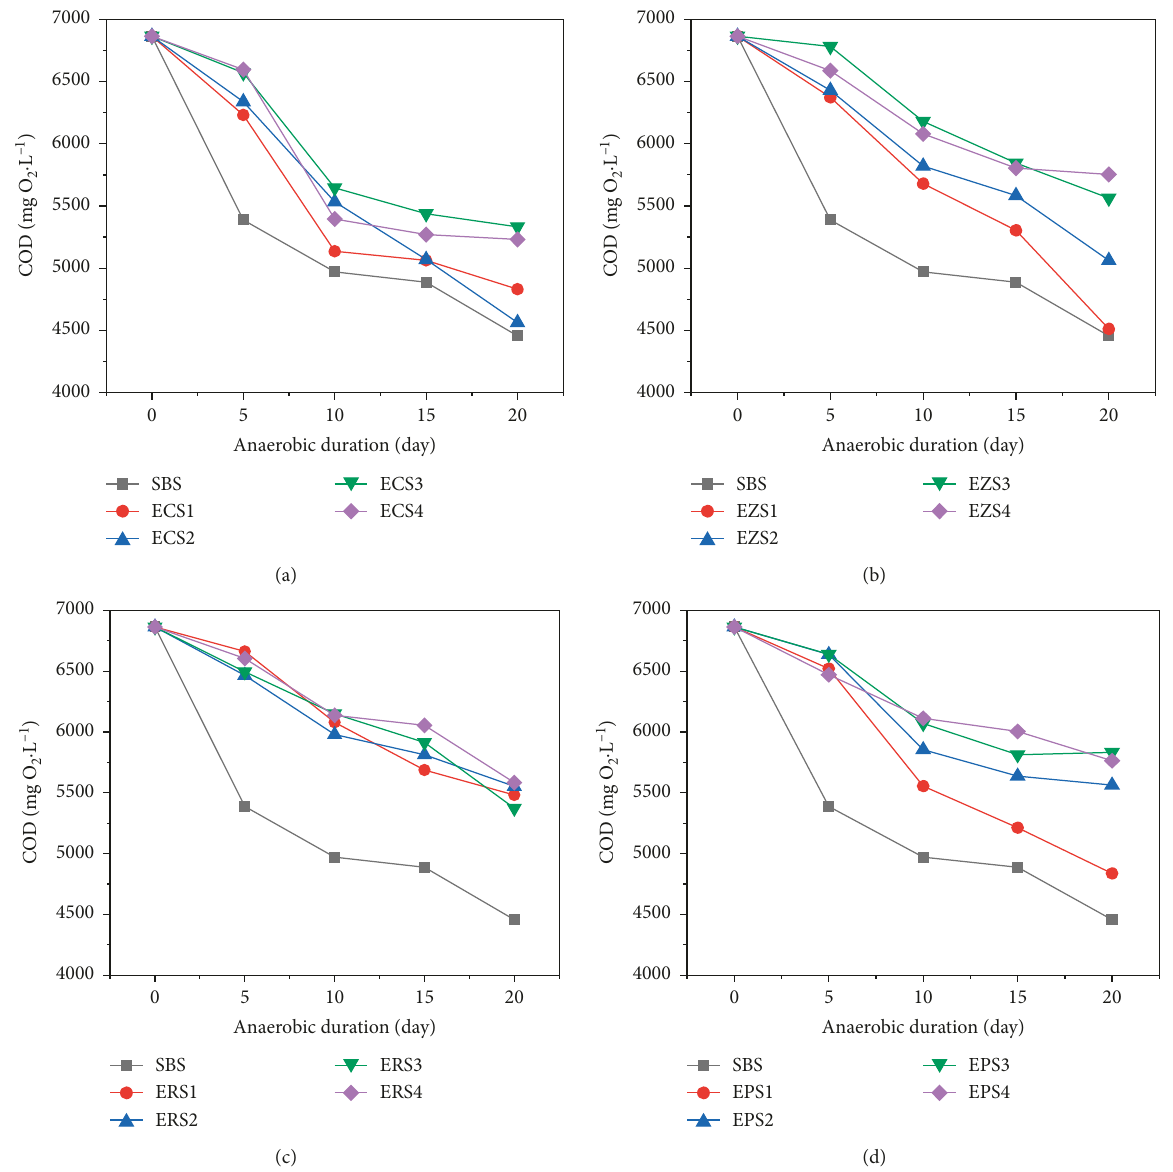
Figure 4: COD removal during anaerobic digestion without and with the presence of copper, zinc, chromium, and